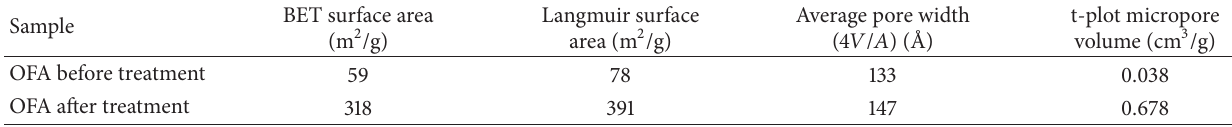
Table 2: Elemental analysis of fly ash by EDX.